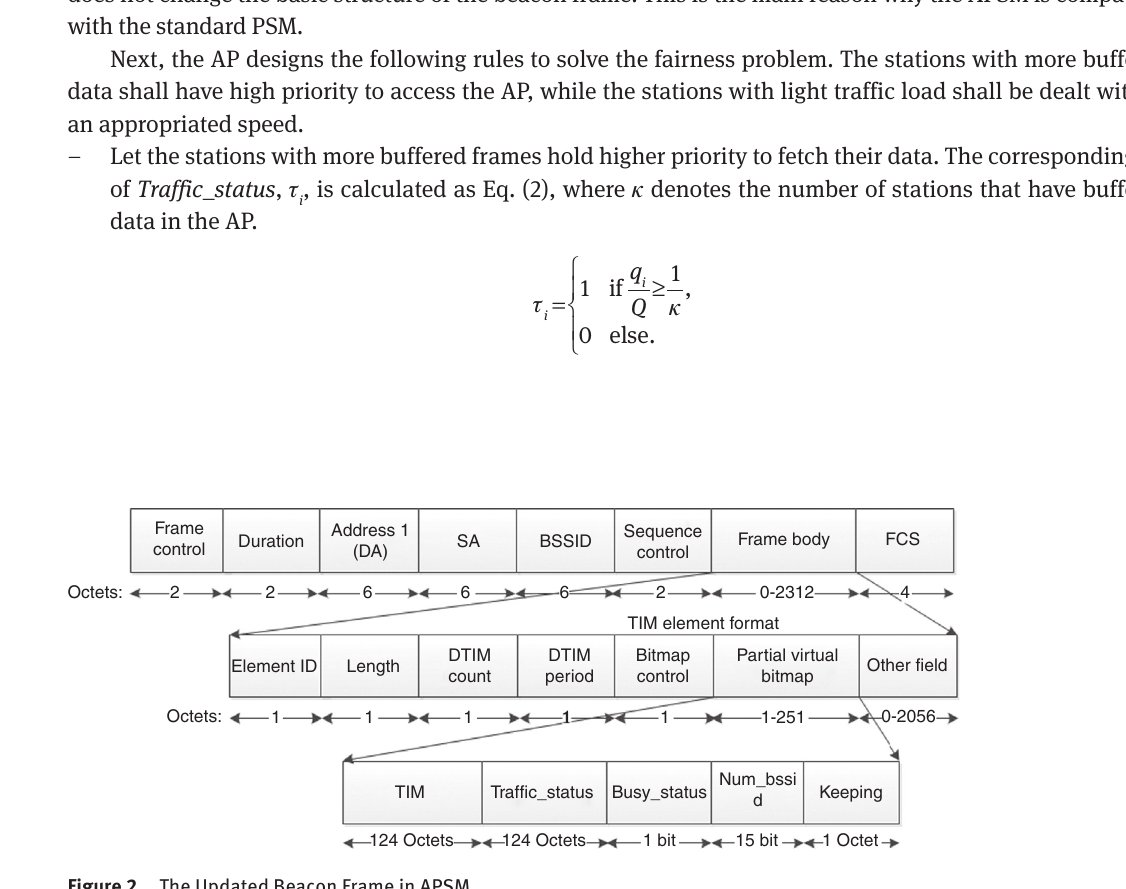
Figure 2. The Updated Beacon Frame in